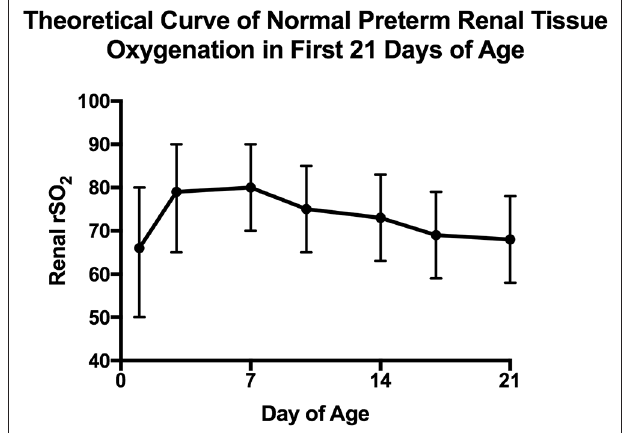
FIGURE 3 | Estimated normal preterm neonatal renal tissue oxygenation in the first 21 days. This figure depicts predicted normal values of renal tissue oxygenation in preterm babies during the first 21 days of life based on studies done by Richter and McNeil (15, 18). For the first 48h, data combined from all 4 groups of the Richter et al. study are expressed as median and interquartile range while for days 3–21 data are extrapolated from the McNeil et al. study that were presented as mean and standard